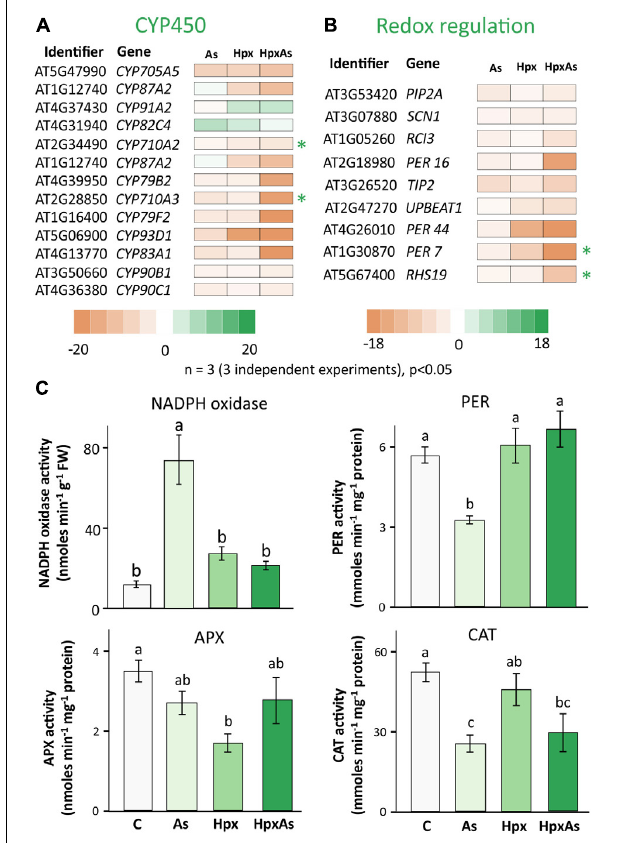
FIGURE 7 | Biochemical and transcriptomic analysis of redox signaling-related regulators of root and root hair growth. (A) Cytochrome P450s (CYPs) gene family comprises heme-containing proteins involved in diverse cell metabolic processes, including redox regulation of growth and development. Transcript accumulation as influenced by As, Hpx, and HpxAs is presented in the heat map for different cytochrome P450s. The genes were initially identified in the search for GO-related terms “Root development” and “Fe-homeostasis.” Included transcripts showed a significant change in expression (–2 ≥ fc linear ≥ 2, FDR p ≤ 0.05) and are assumed to be relevant for the HpxAs-induced root growth phenotype. (B) Redox regulatory transcripts involved in root development, other than CYP450s presented above, were selected for their significant response (–2 ≥ fc linear ≥ 2, FDR p ≤ 0.05) and are presented in heat map. Transcripts with unique response to HpxAs (–2 ≥ fc linear ≥ 2 for HpxAs, FDR p ≤ 0.05 and either response below this threshold for As, Hpx or response statistically not-significant) are marked with an asterisk. The complete lists for all selected CYP450s and other redox regulatory genes are provided in Supplementary Table 6 . (C) NADPH dependent XTT reductase activity was measured in crude membrane extracts to analyze stress effects on NADPH oxidases. The extract was also tested for its superoxide specificity by using SOD randomly for certain samples to demonstrate inhibition of XTT reduction (data not shown). Guaiacol peroxidase (PER), ascorbate peroxidase (APX), and catalase (CAT) were measured for their enzyme activity in root extracts. All enzyme activity data are means ± SE, n = 6 (3 independent experiments). Micrographs showing ROS generation in different cell layers in the RH zone, based on 2’, 7’-dichlorodihydrofluorescein diacetate (H 2 DCFDA) fluorescence are given in Supplementary Figure 4